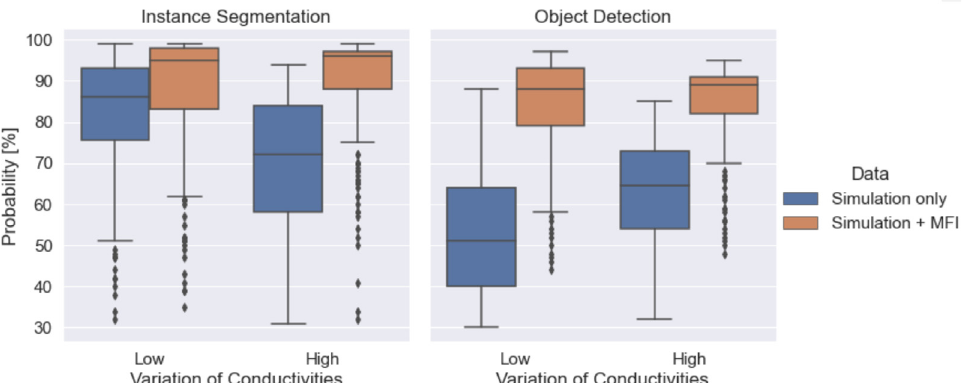
Fig. 7. Probabilities of busbar detection for the two neural network types instance segmentation (left) and object detection (right), depending on the variation of the training data sets and the addition of real measurement data. Real measurement data signi fi cantly increase the probabilities, higher variation of training data had only a small effect, in some cases detrimental.